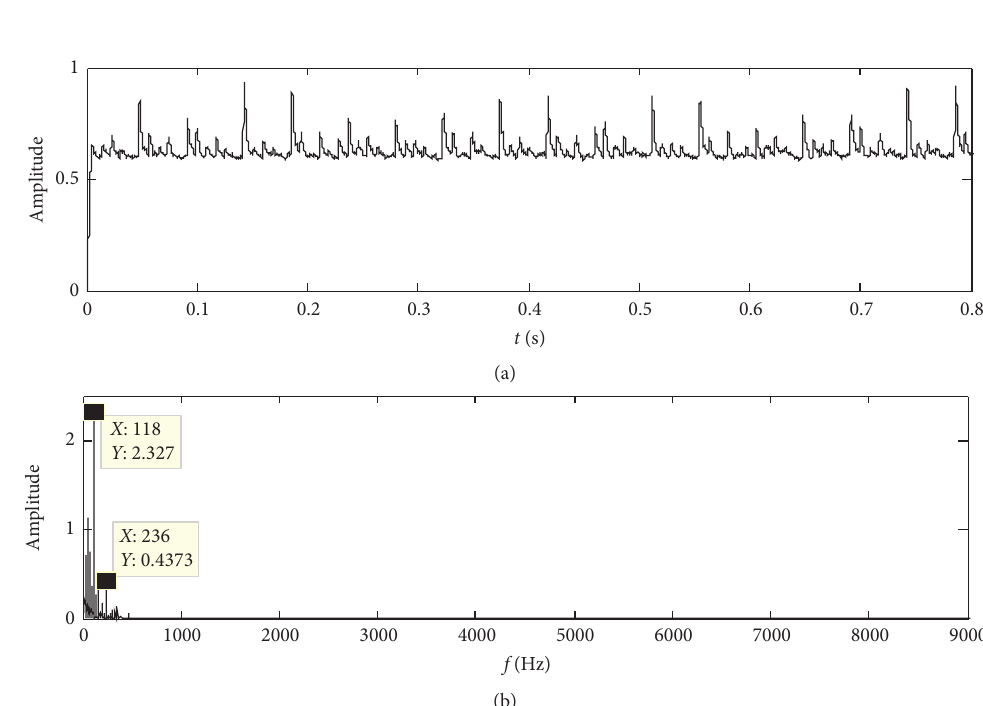
Figure 15: Output signal of the asymmetrical piecewise linear